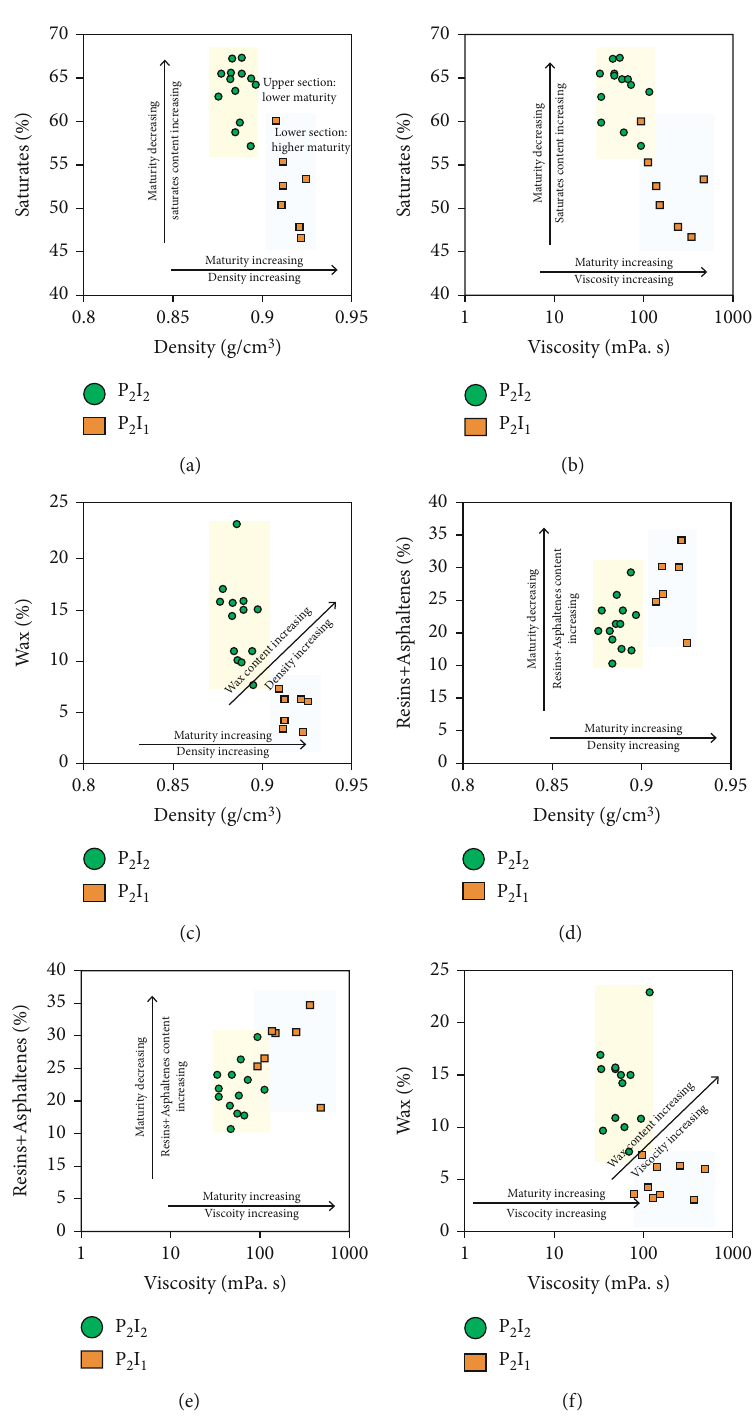
Figure 9: Cross-diagrams of (a) density versus the content of saturates, (b) viscosity versus the content of saturates, (c) density versus the content of wax, (d) density versus the content of resins + asphaltenes , (e) viscosity versus the content of resins + asphaltenes , and (f) viscosity versus the content of wax, for the crude oil sample in the Lucaogou